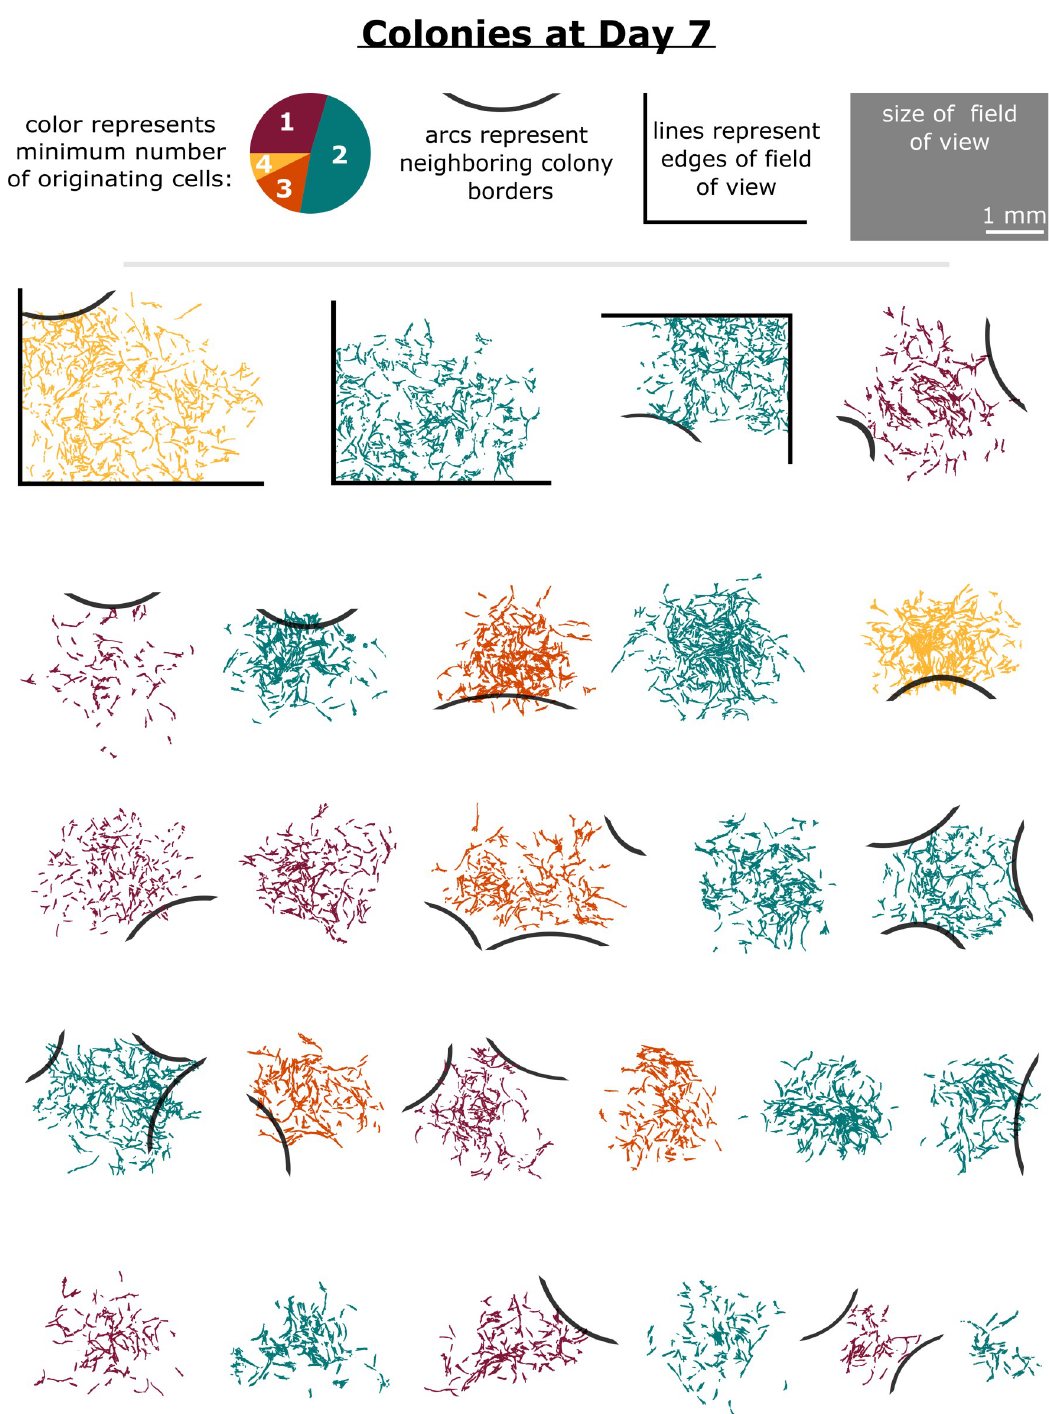
Fig 2. Colonies varied by size, confluency, number of originating progenies, and degree of isolation after seven days of growth. Binarized and recolored phase contrast images of all analyzed colonies after seven days of growth. The color of each imaged colony was altered to represent the number of originating cells associated with each colony, as analyzed by time lapse image analysis at the single-cell level up to Day 4. Borders of neighboring colonies that were either touching or overlapping the colonies studied are represented as black arcs and were traced based on the original phase contrast images. The size of the 16 montaged fields of view at Day 7 is also provided for reference. No statistical correlation was found between the number of cells the colony originated from and colony diameter, confluency, or number of neighboring colonies. (See S2 Fig for further details.) Colonies are ordered by approximate diameter. Unaltered phase contrast images of all colonies are provided in S1 Fig.